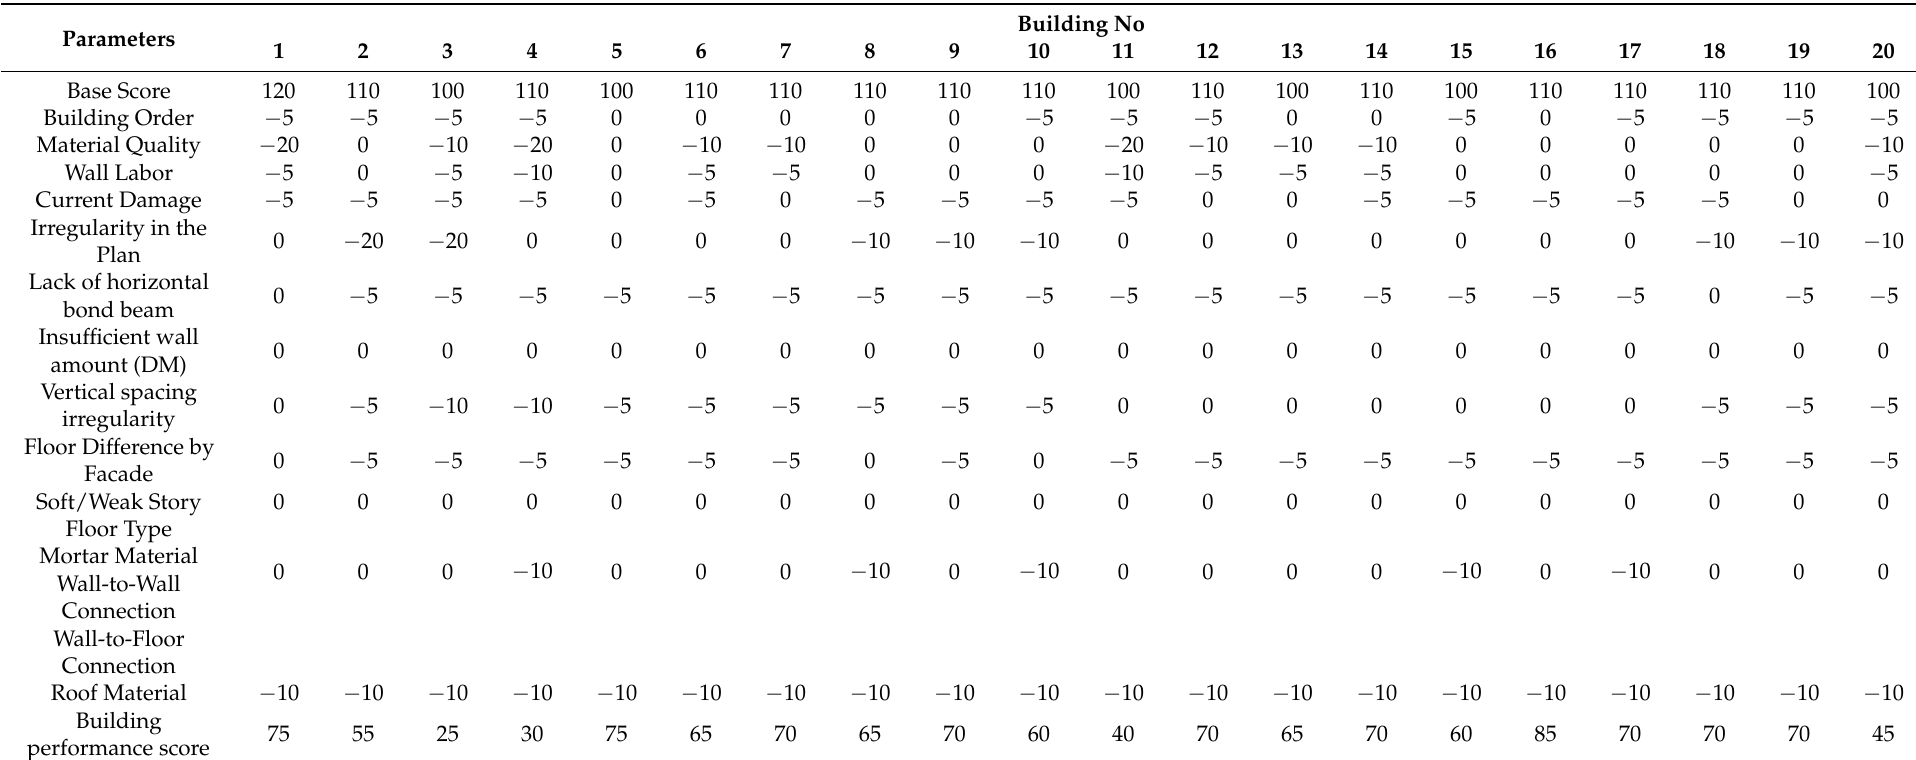
Table 14. Parameter values and structural result scores of the examined